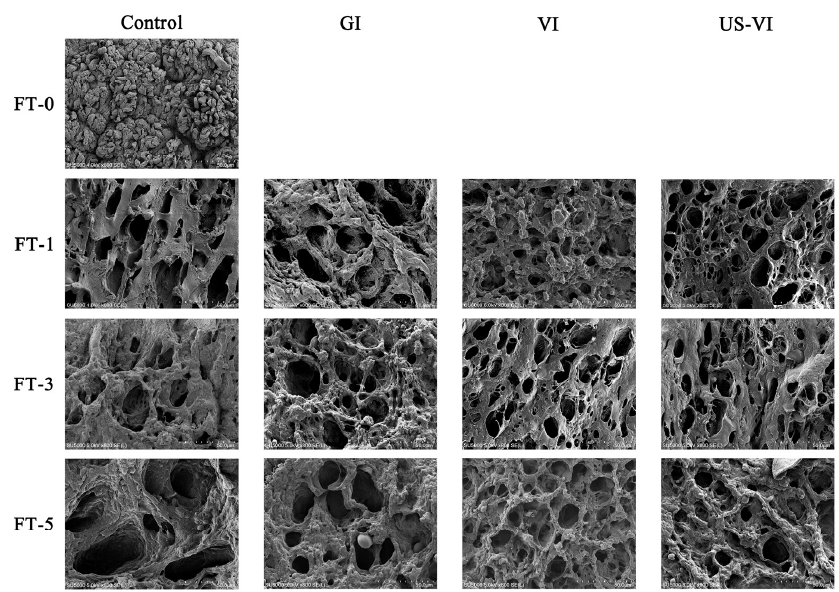
Foods 2022 , 11 , x FOR PEER REVIEW Fig 5 Figure 5. Changes in microstructural structure of the scallop adductor muscle induced by freeze–thaw cycles (magnification: 800 × ) (FT-0, 1, 3, and 5: numbers of freeze–thaw cycles).